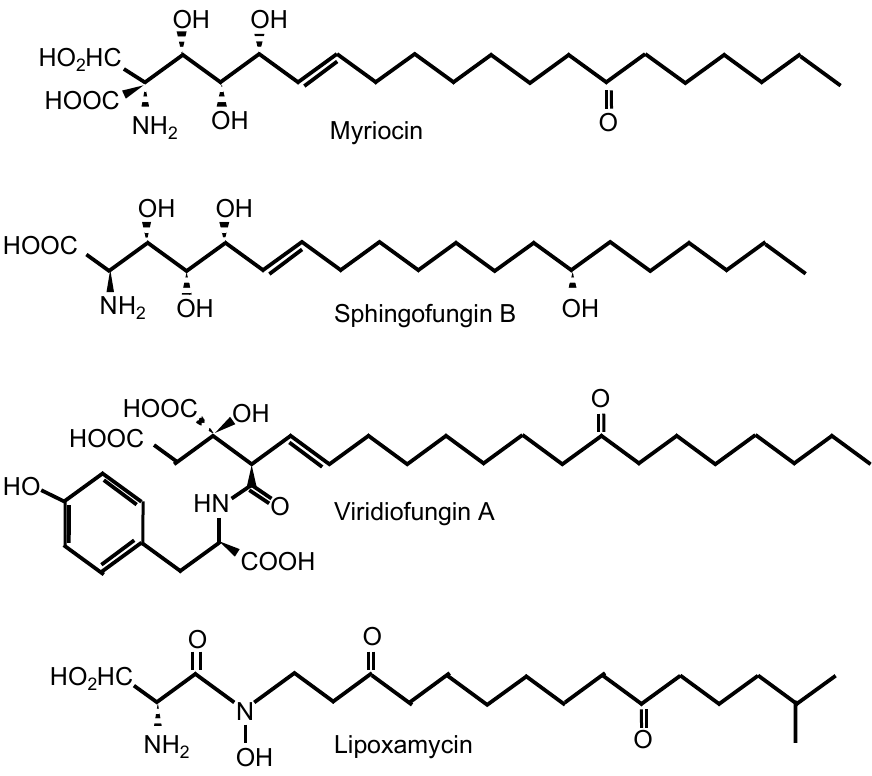
Figure 2. Inhibitors of serine palmitoyl transferase.